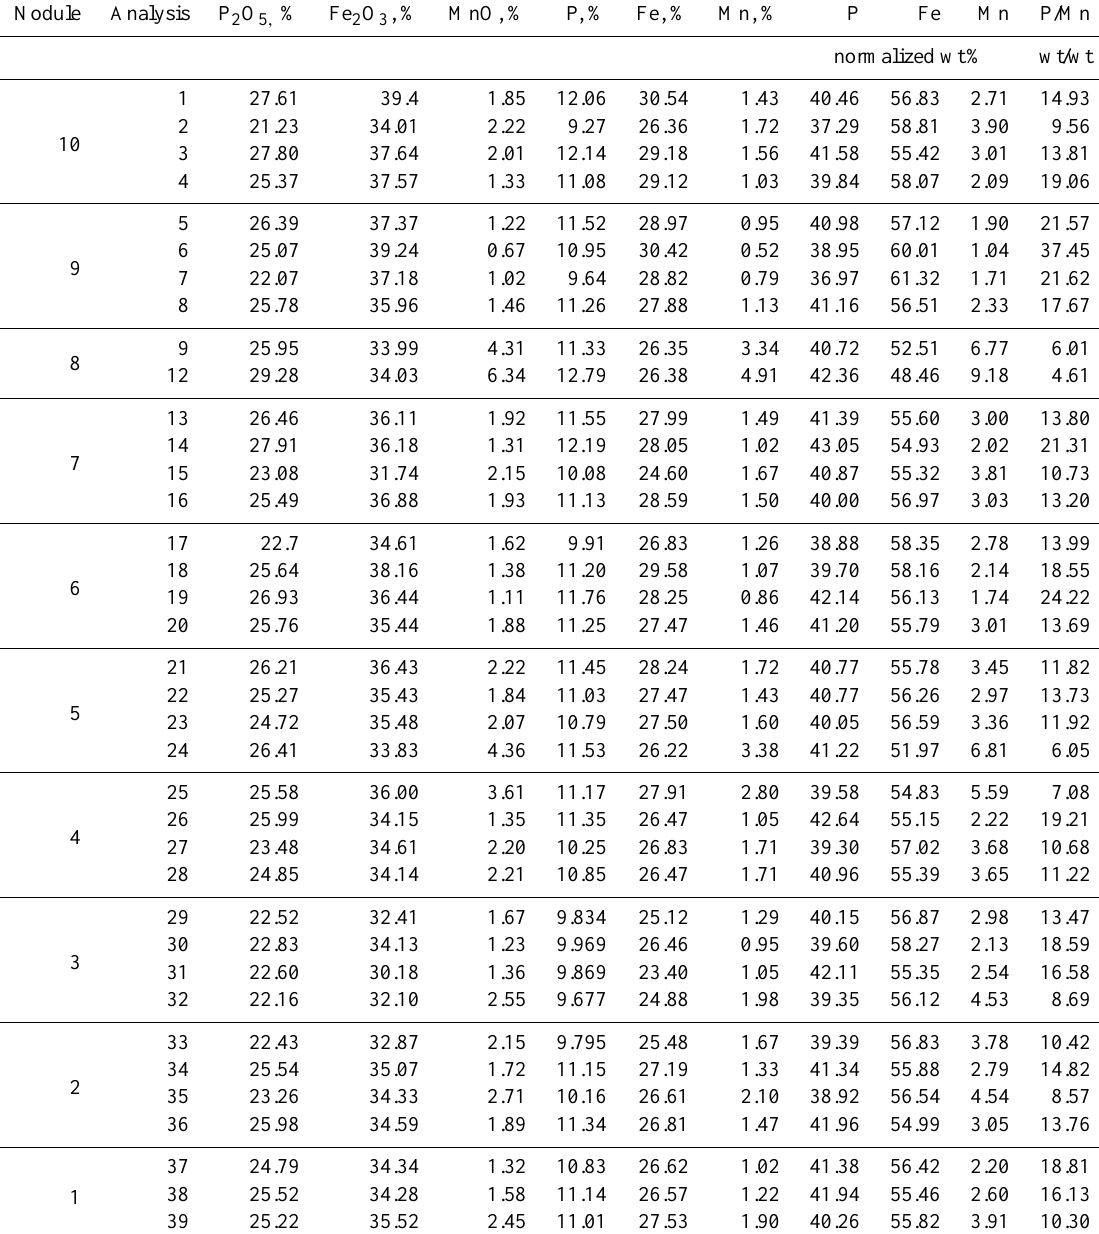
Table 1. Electron microprobe analyses of selected vivianite nodules from Lake El’gygytgyn. Nodule